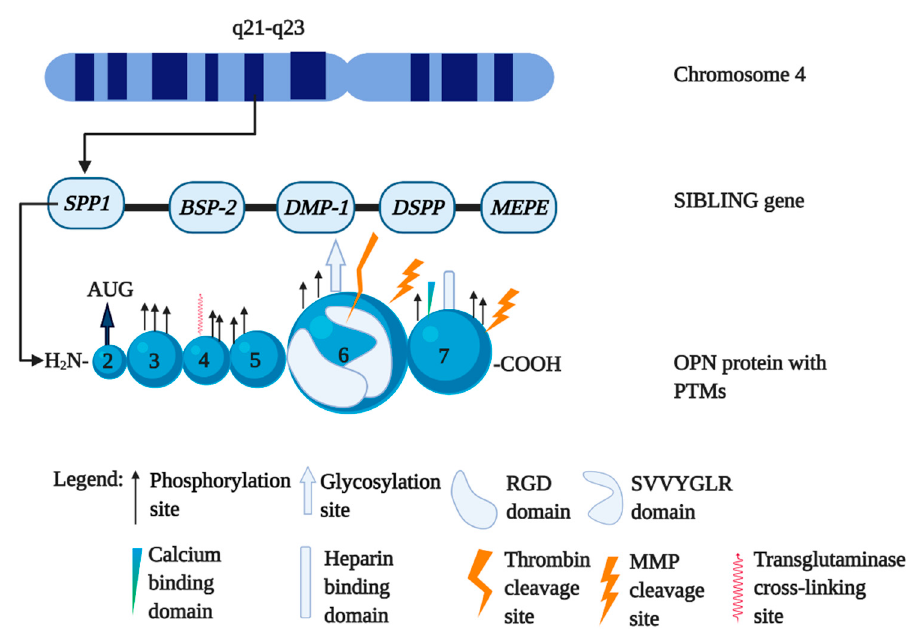
Figure 1. Human secreted phosphoprotein-1 ( Spp-1 ) gene genetic location and the post translational modification (PTM) sites in osteopontin (OPN) protein. OPN gene Spp-1 is located on human chromosome 4 (4q22.1) at the 5’ end of the cluster of the five genes, collectively called the “SIBLING family”. OPN messenger RNA (mRNA) can be translated into a 314-aa OPN-FL,